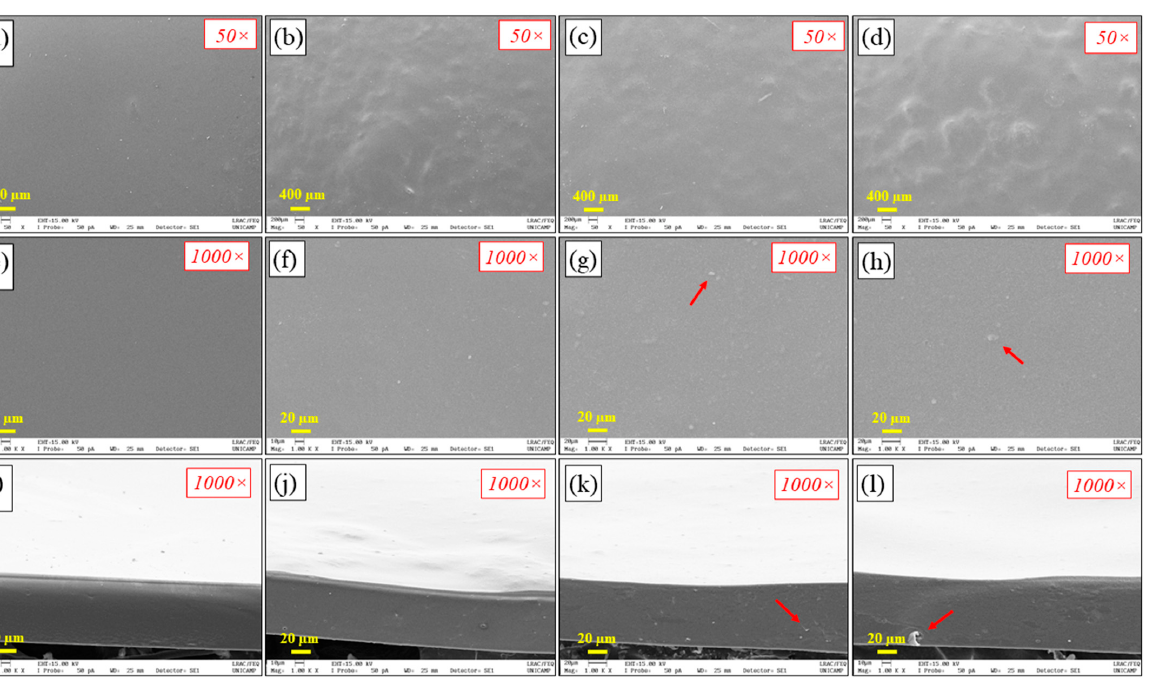
Figure 1. Surface and cross-sectional scanning electron microscopic images at different magnifications of the CH/WKG ( a , e , i ), CH/WKG/3%SiO 2 ( b , f , j ), CH/WKG/6%SiO 2 ( c , g , k ), and CH/WKG/10%SiO 2 samples ( d , h , l ). The red arrows indicate defective points in the microstructure of the films.